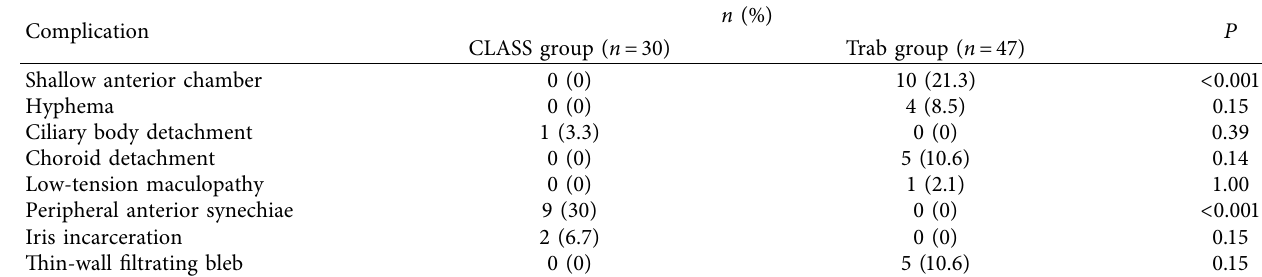
Table 5: Postoperative complications in CLASS versus Trab